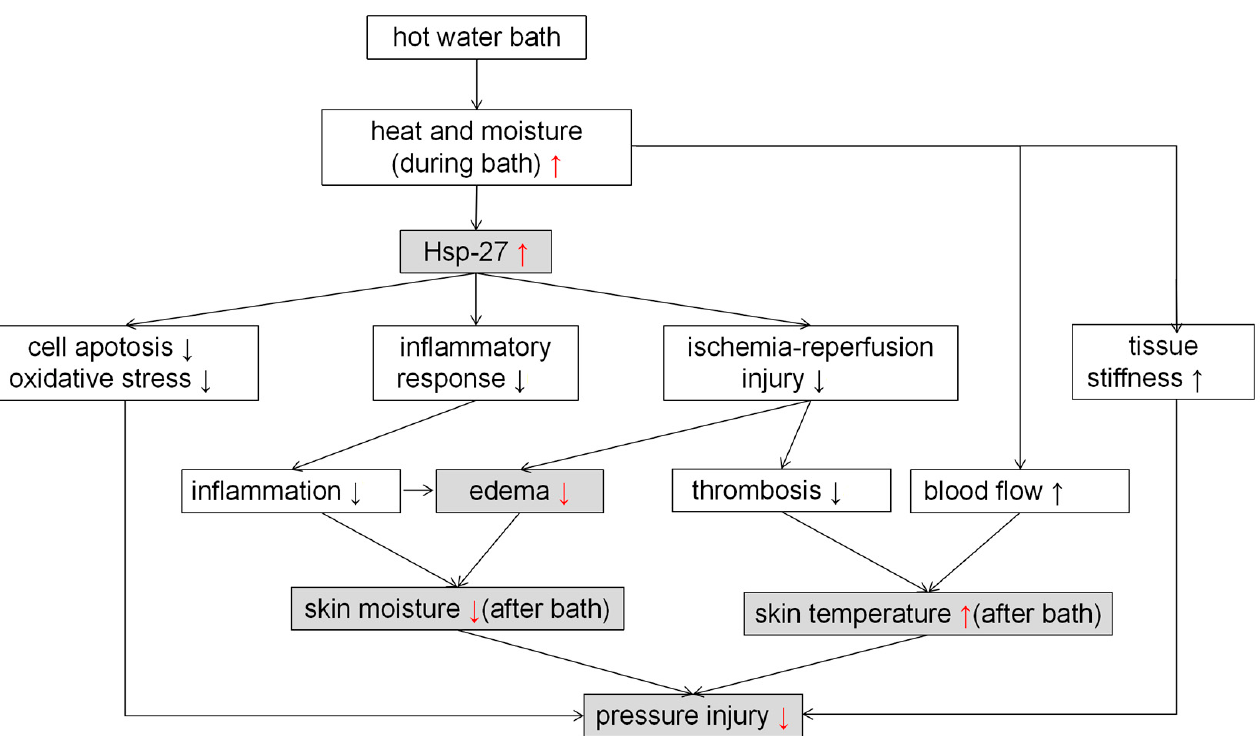
Figure 5. Effect of heat shock preconditioning on prevention of PI. The results of this study are marked as gray. References are in square parentheses. Red arrow ( ↑↓ ) means increase ( ↑ ) or decrease ( ↓ ) compared with the control